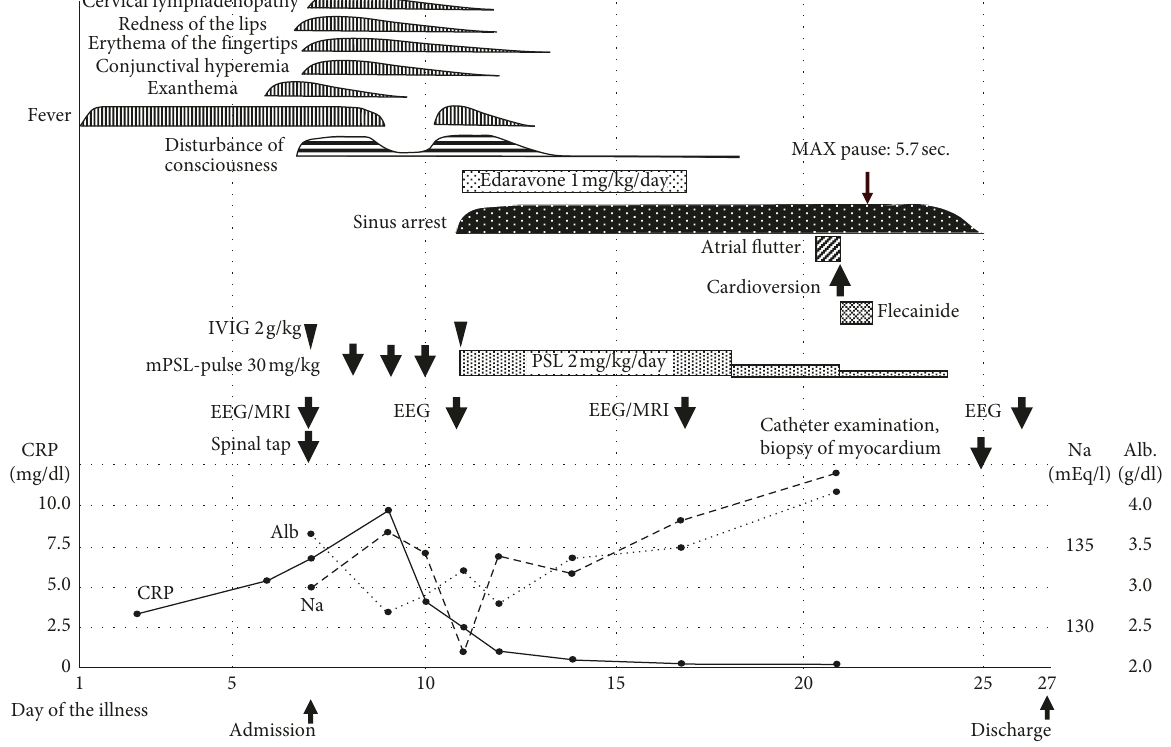
Figure 2: Clinical